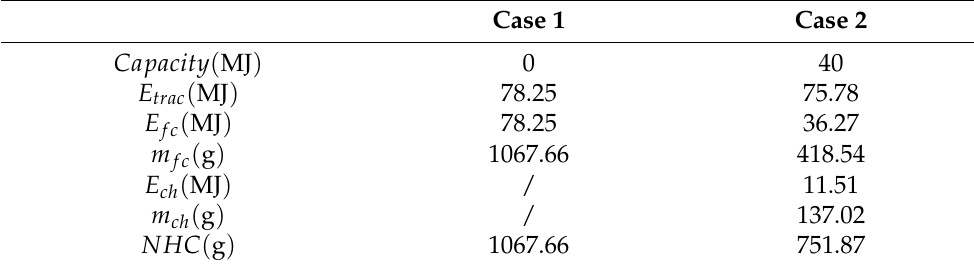
Table 4. Key parameter settings and optimization results for Case 1 and Case 2.